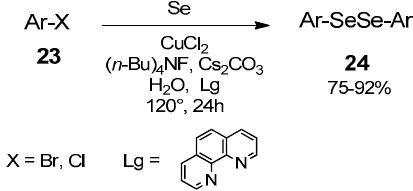
Figure 15. Cu-catalyzed synthesis of diselenides in phase transfer conditions.